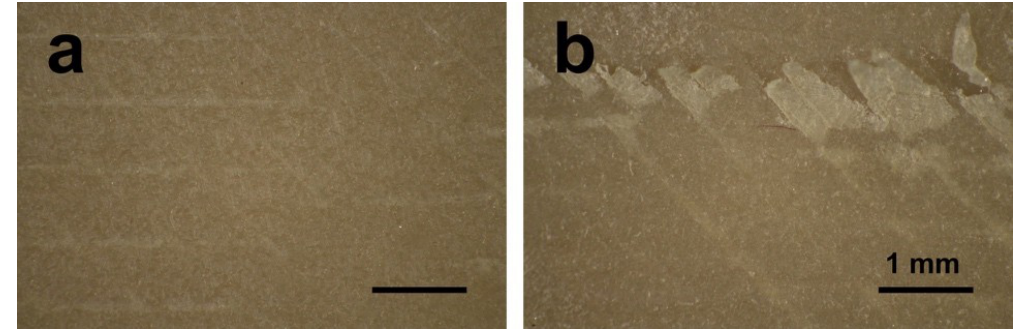
Figure 9. Optical micrographs of sandblasted PEEK samples ( a ) under 0.1 MPa pressure; ( b ) under 0.5 MPa pressure.